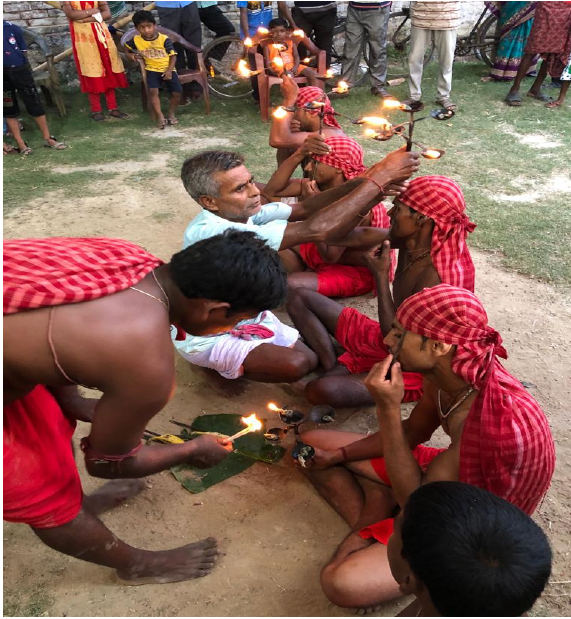
Figure 6. Skin piercing with iron rods and fire lamps placed on them.